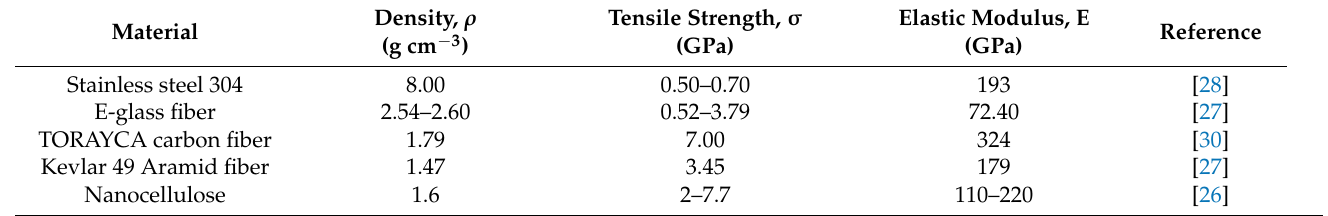
Table 1. Density and mechanical properties of high-performance materials in comparison to